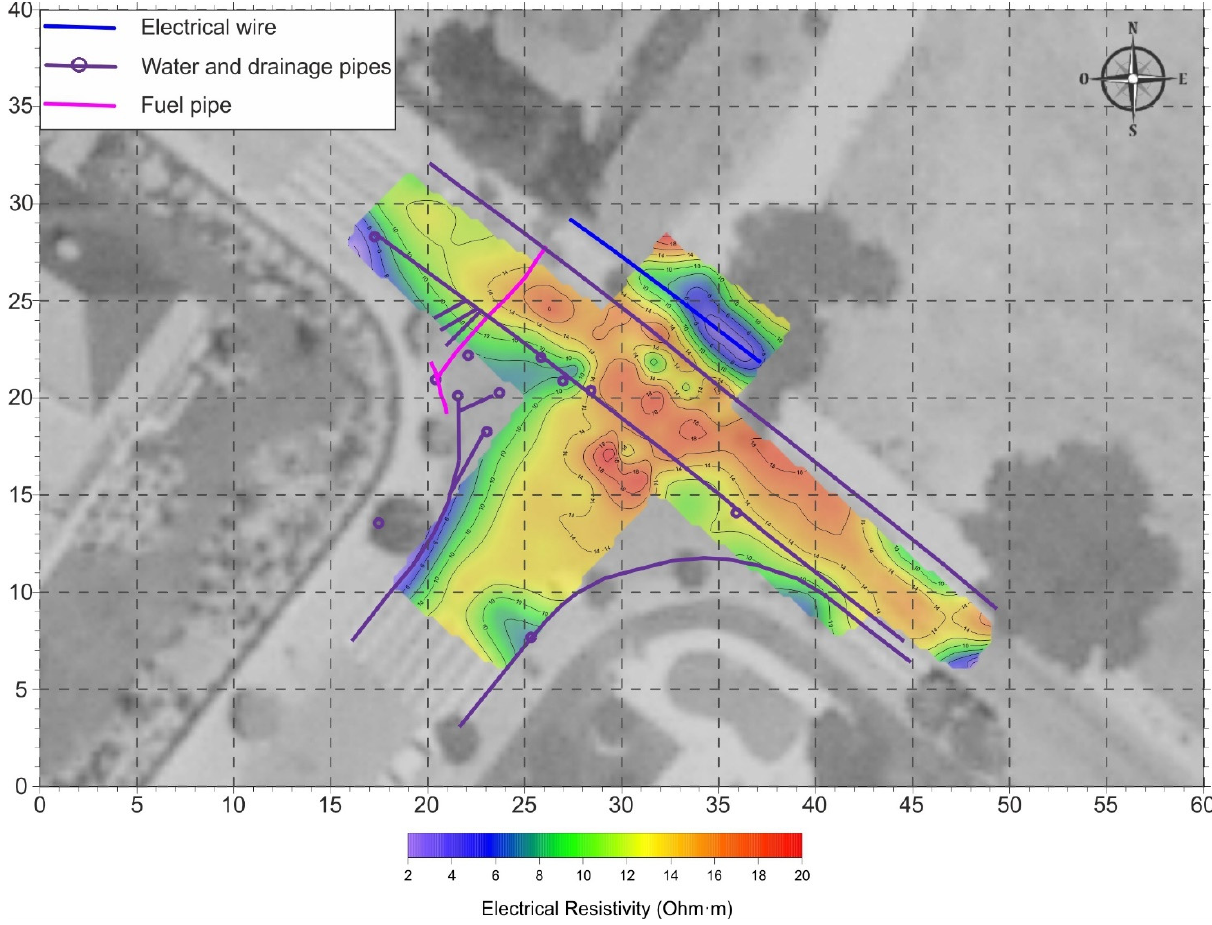
Figure 7. Resistivity distribution map obtained from electromagnetic conductivity measurements. The values represented correspond to 1.1 m depth.